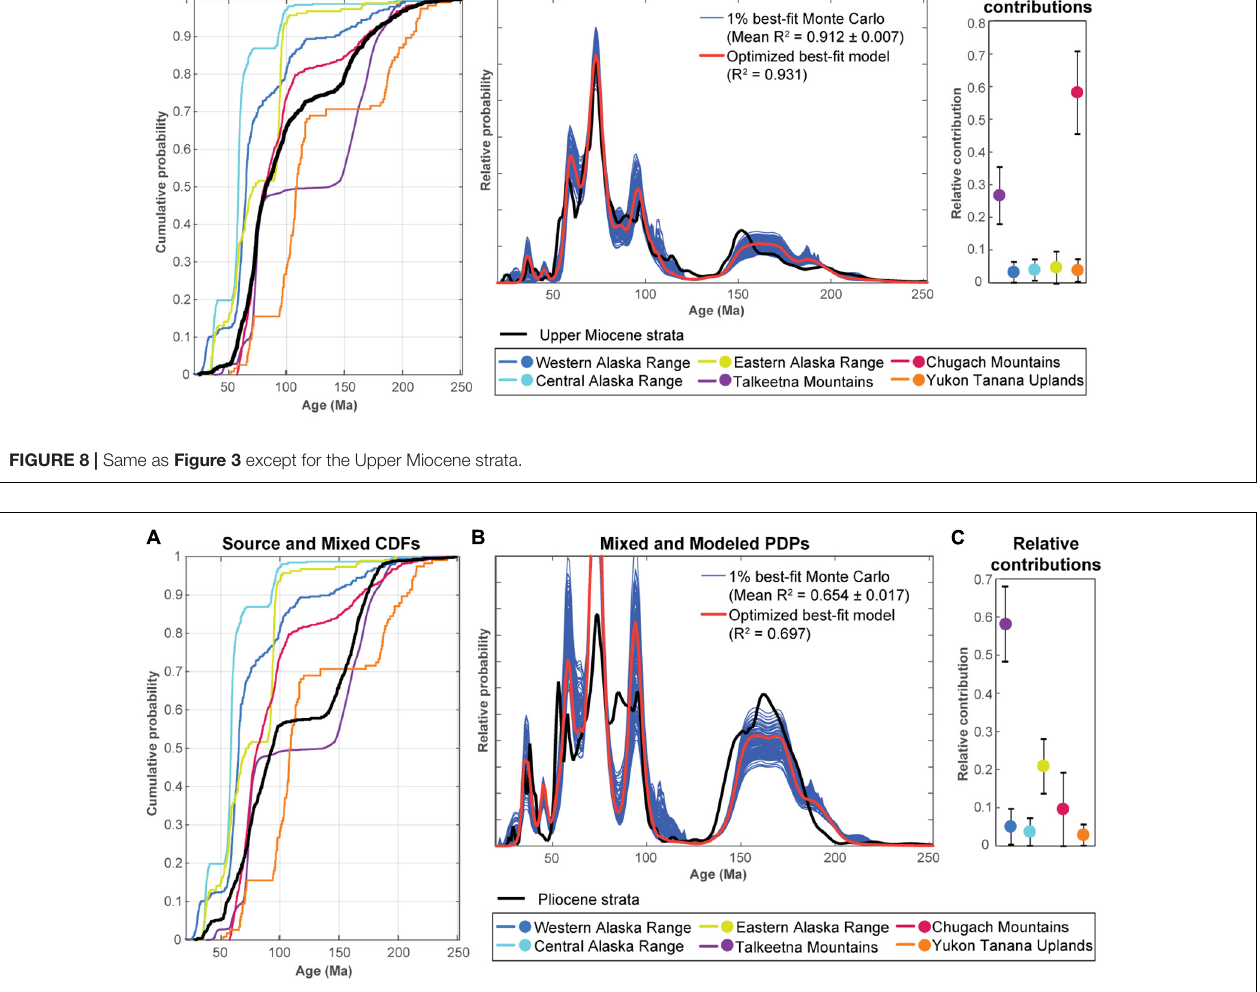
FIGURE 9 | Same as Figure 3 except for the Pliocene